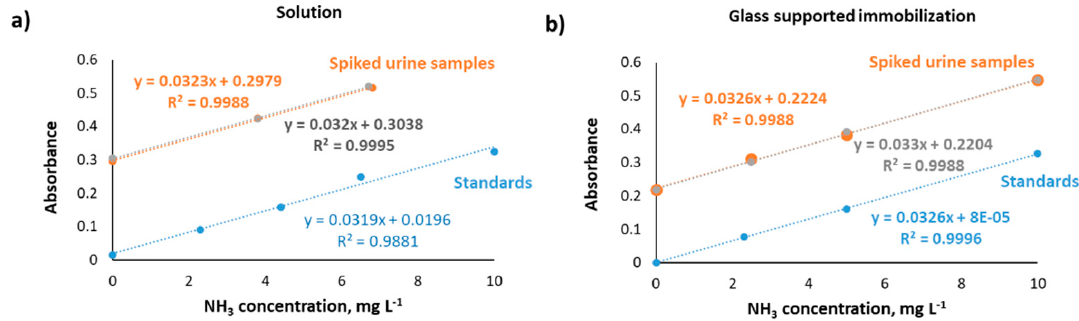
Figure 5. Calibration curves for hydrolyzed urea standards (blue) and spiked urine samples ( n = 2, orange and grey) for urea catalysis by means of ( a ) urease enzyme in solution and ( b ) glass-supported urease immobilization.